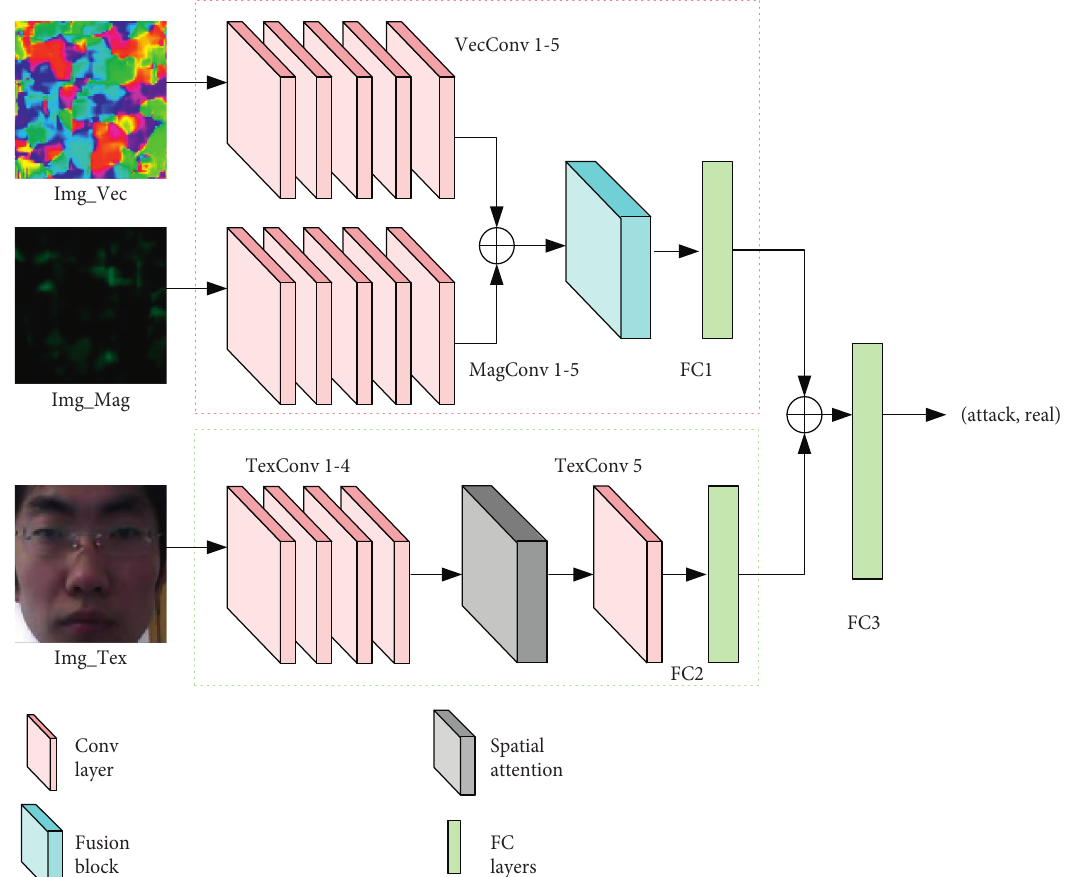
Figure 5: The dynamic and texture features fusion attention network (DTFA-Net) architecture. The figure omits the ReLU and pooling layers after the convolution layer, and the id of the convolution is shown on the top. Color code used is as follows: pink � convolution; blue � fusion block; gray � spatial attention; green � fully connected